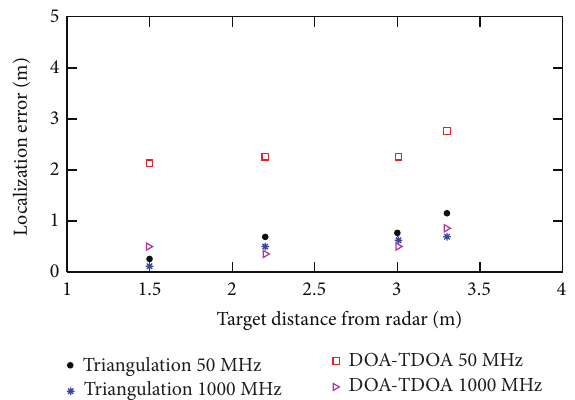
Figure 21: Localization errors from measurements in a radio anechoic chamber.